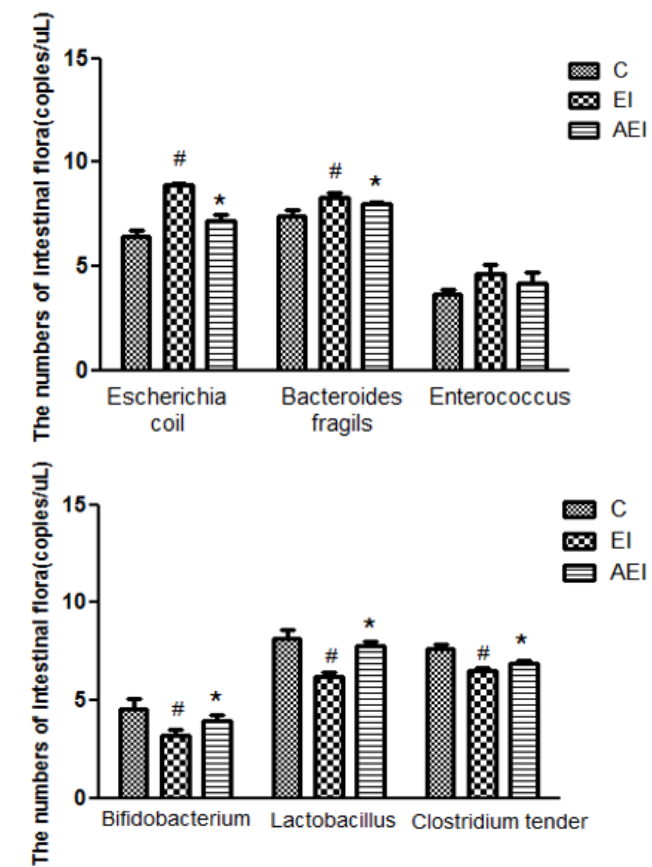
Clostridium tender .